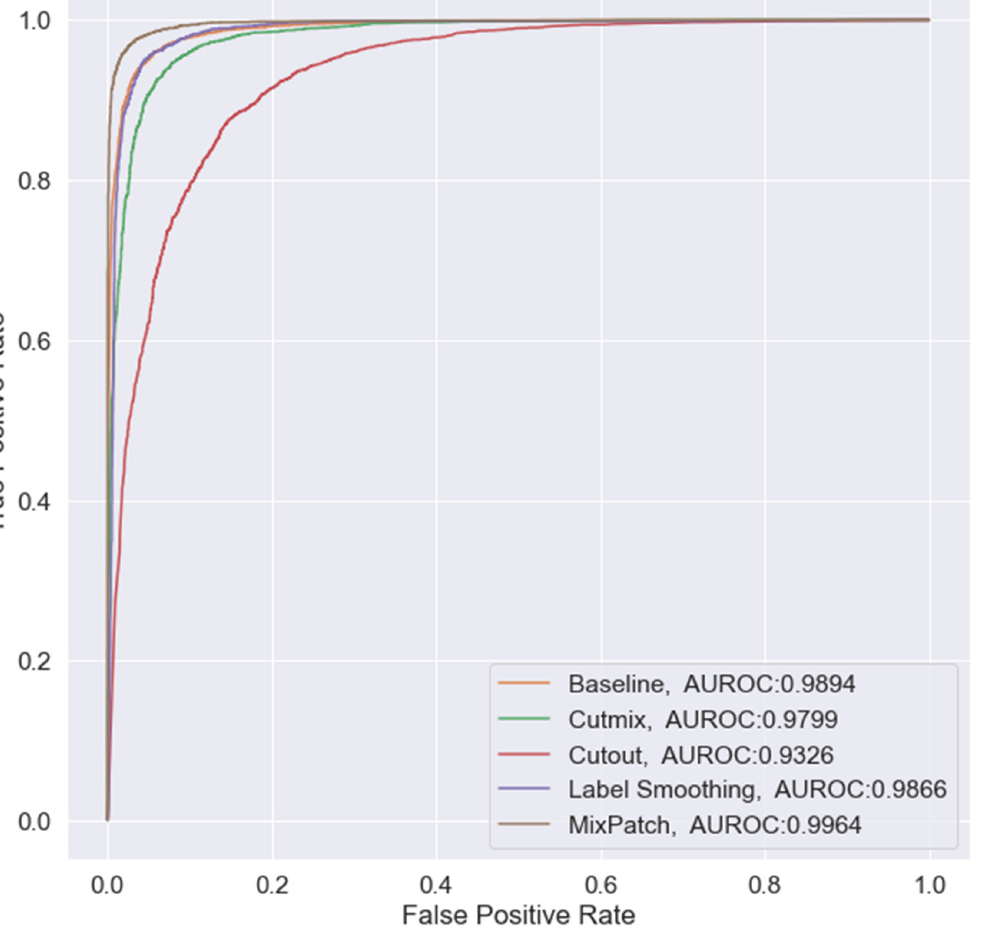
Figure 3. ROC curve for the different methods.